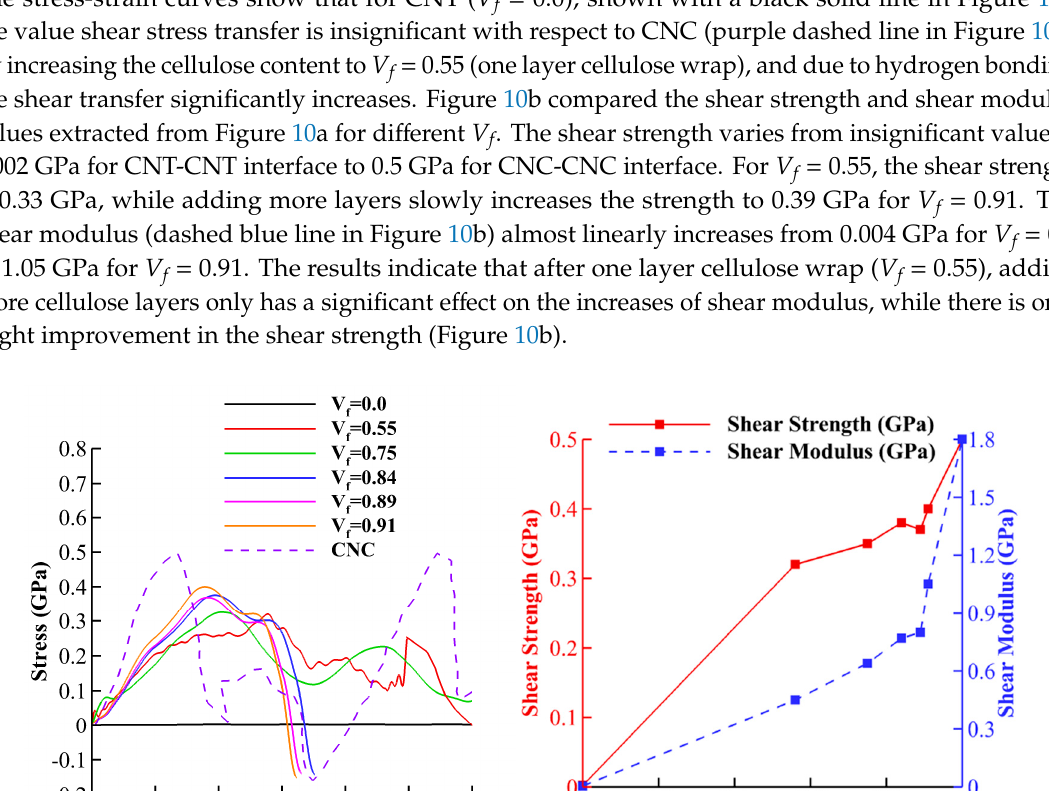
Figure 9. The variation of surface energy is compared with the strength and Young’s modulus by increasing cellulose content for the ( a ) tensile test and ( b ) compression test.